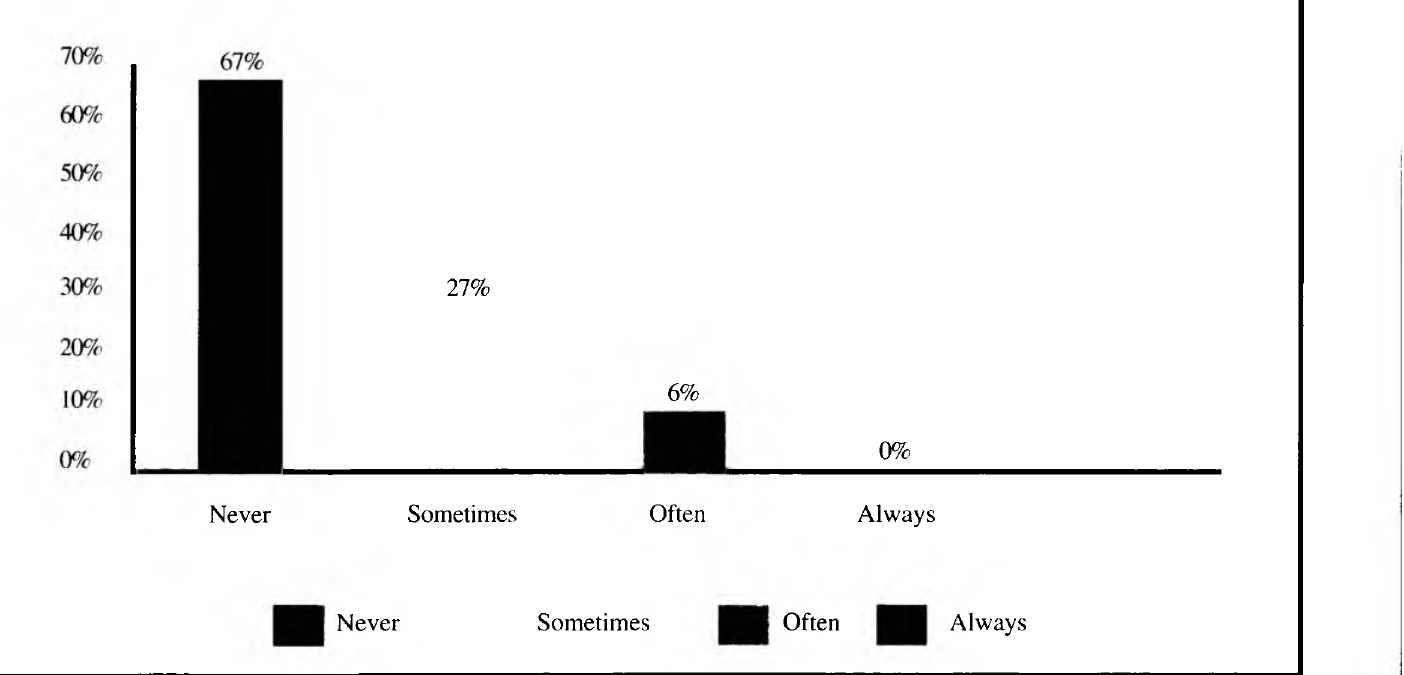
Figure 3: Forms of spitefulness experienced by the participants